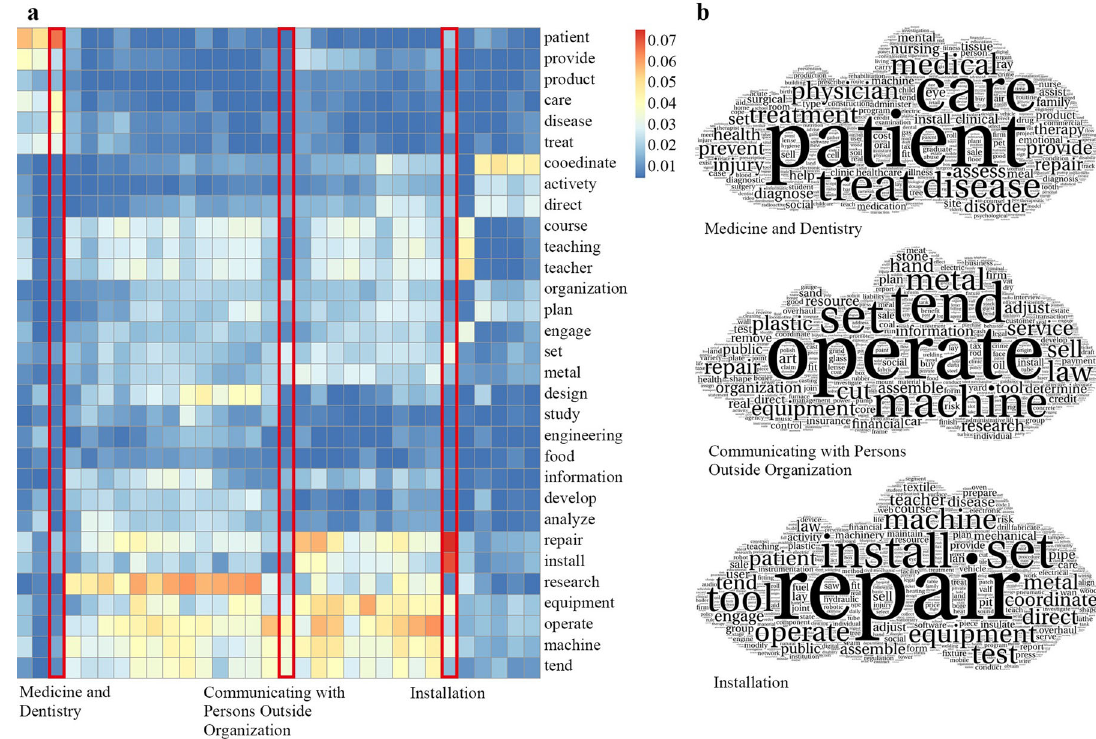
Fig. 1 Mutual information between O*NET tasks and skills. a The heat map is drawn based on the mutual information of the task-skill pairs, showing the heterogenous structure of the task-skill relationships. b Task clouds of three skills: Medicine and Dentistry, Communicating with Persons Outside Organization and Installation. The word size is proportional to the value of the mutual information